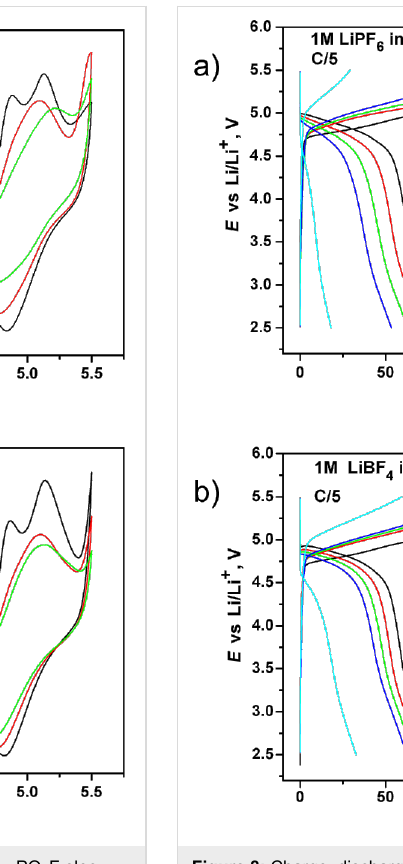
Figure 7: Cyclovoltammetry curves of the Li 2 Co 0.9 Mn 0.1 PO 4 F elec- trodes in the commercial (a) and the sulfone-based (b) electrolytes recorded at 0.1 mV s − 1 .